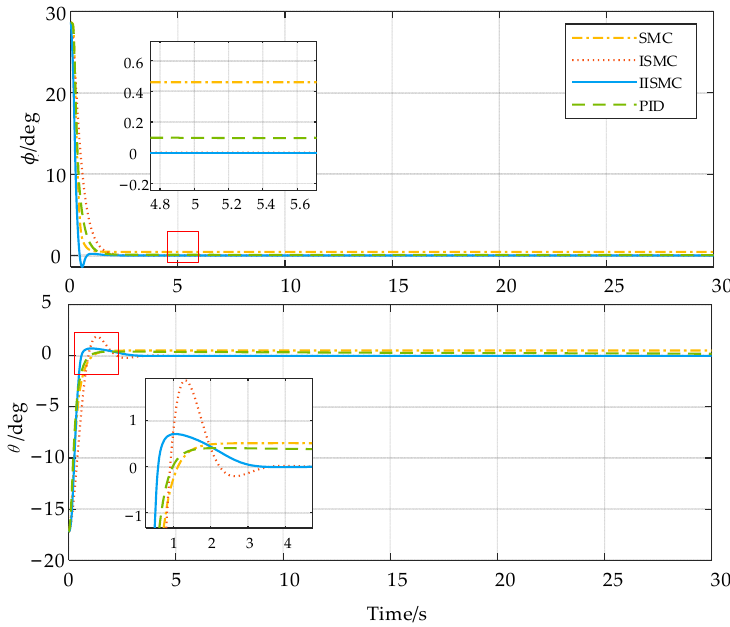
Figure 10. Attitude angles under four control methods in Scene 2.